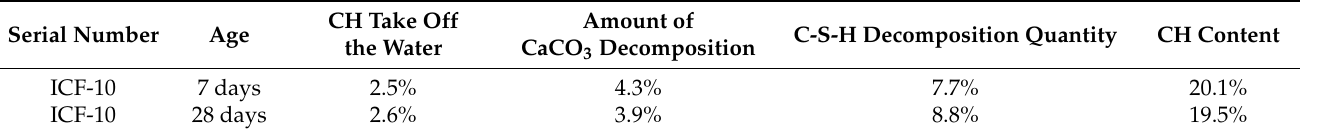
Table 6. TG test of the yield of each